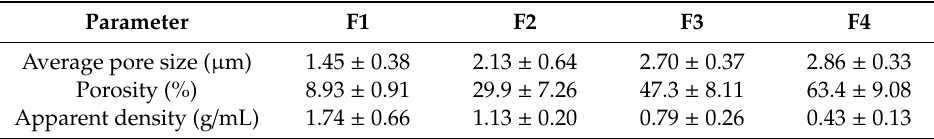
Table 2. Pore characteristics of formulations F1–F4 of porous PLGA